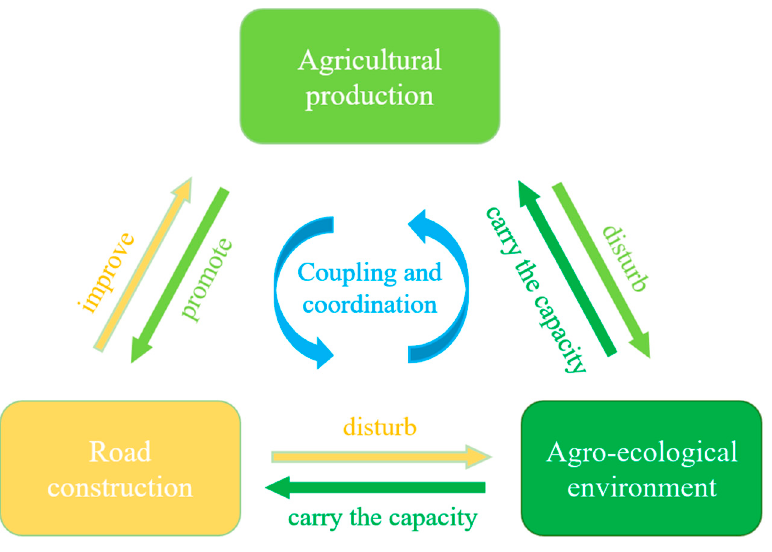
Figure 2. Research